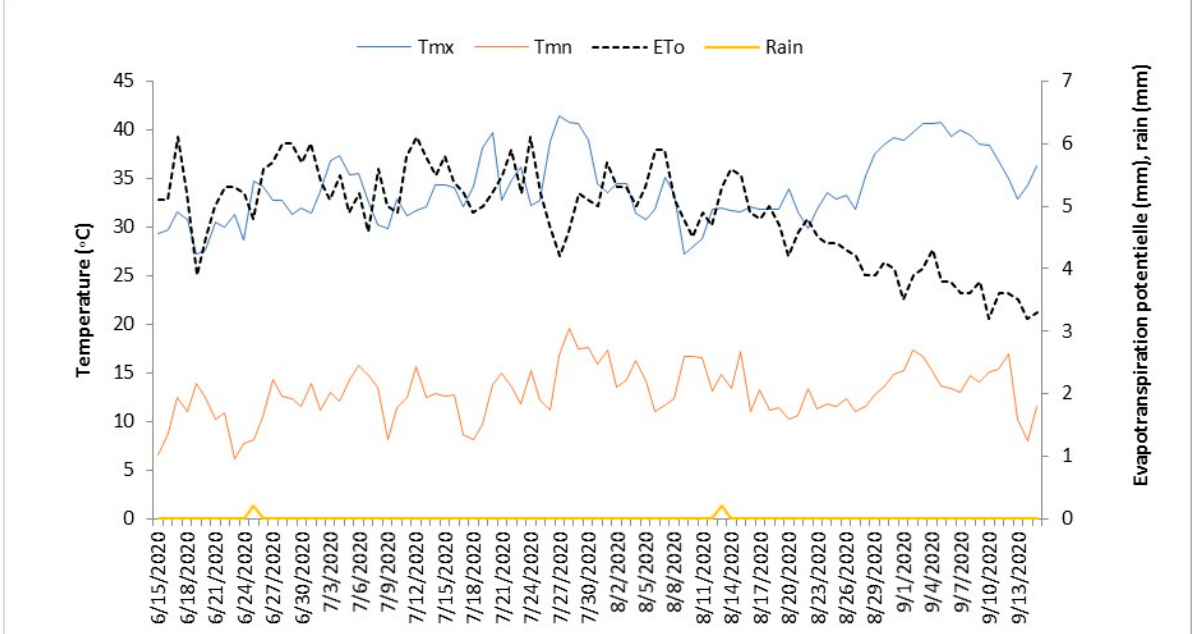
Figure 1. Daily precipitation (P, mm), maximum (Tmax, °C) and minimum (Tmin, °C) air temperature, and potential evapotranspiration (ETo, mm day-1) recorded at the wetland site during the sampling period.